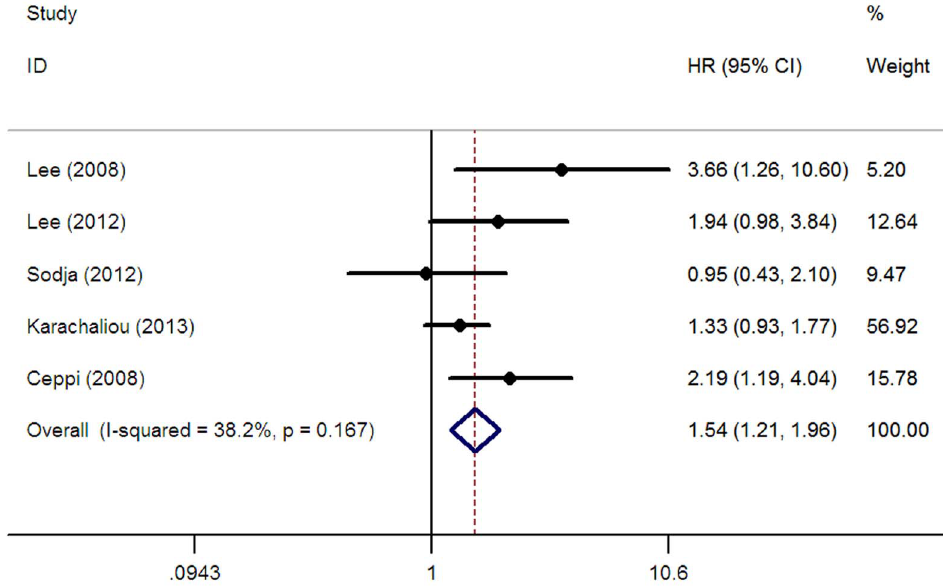
Figure 4. Forest plot for the association between ERCC1 level and overall survival (OS) in LS-SCLC patients receiving platinum- based chemotherapy.